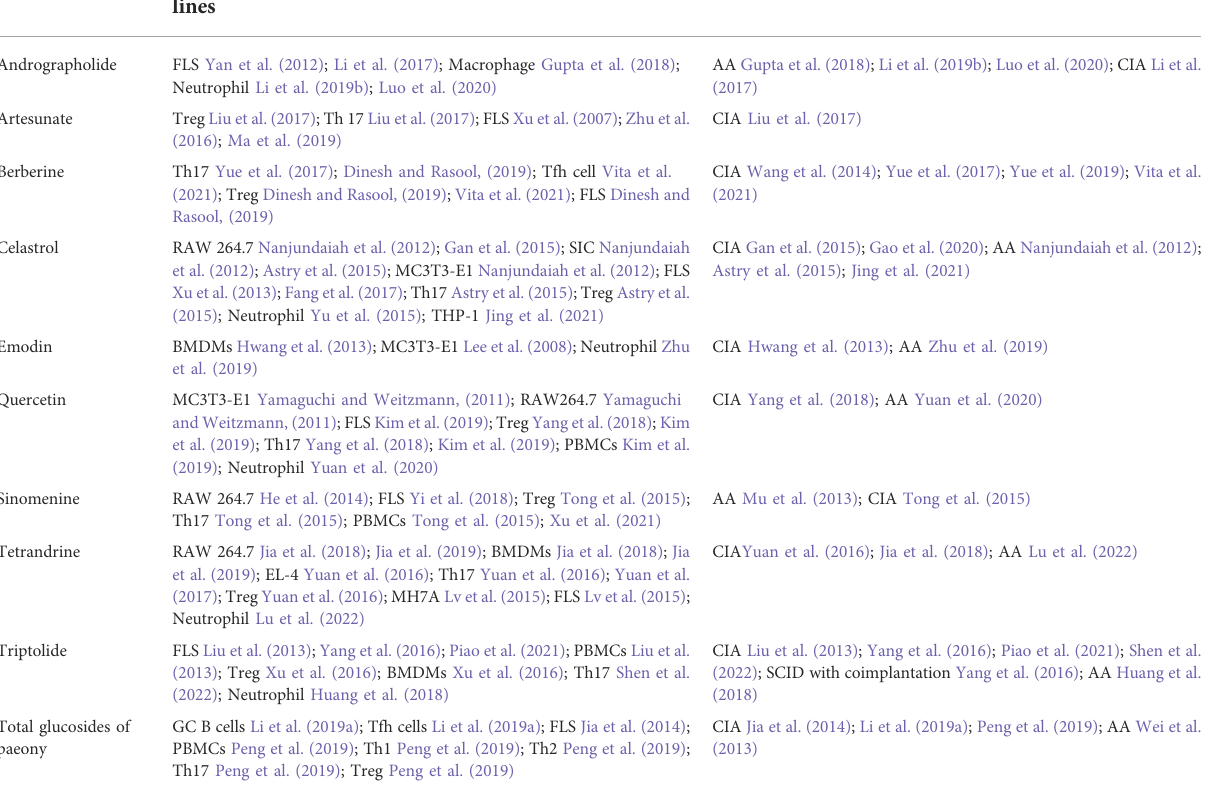
TABLE 1 Targeted cells and animal models used in the studies of active components from TCM.